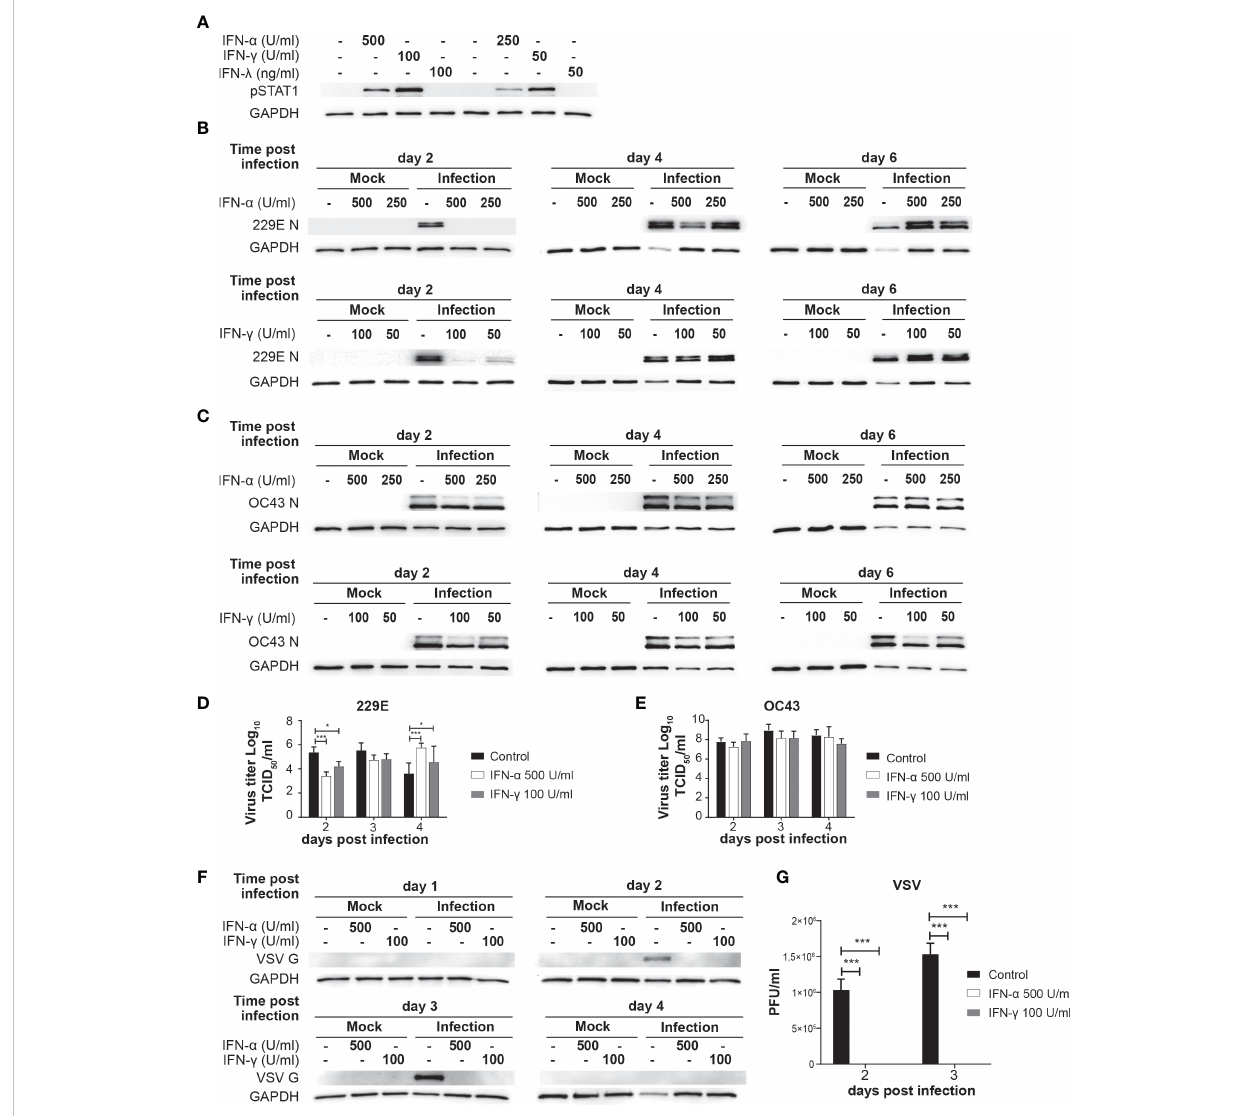
FIGURE 1 IFN treatment delays 229E but not OC43 infection. (A) MRC5 cell were left untreated or treated with IFN- a (500 and 250 U/ml), IFN- g (100 and 50 U/ml) or IFN- l (100 and 50 ng/ml) for 30 min. STAT1 activation was determined by western blot analysis using anti phospho-STAT1 and GAPDH antibodies. (B, C) MRC5 cells were left untreated or treated with IFN- a or IFN- g for 18 hours, and then challenged with 229E (B) or OC43 (C) infection at MOI of 0.01. Western blot analysis of viral protein was conducted using anti 229E N protein (B) , OC43 N protein (C) and GAPDH antibodies. (D, E) TCID 50 assay was performed to measure the progeny virus of 229E or OC43 infected MRC5 cells left untreated or treated with IFNs (n=3). (F, G) MRC5 cells were left untreated or treated with IFN- a (500U/ml) or IFN- g (100U/ml), and then challenged with VSV at MOI of 0.0001. VSV infection was determined by (F) western blot analysis using anti VSV G and GAPDH antibodies and (G) plaque assay using L929 cells (n=3). The amount of progeny virus is shown as plaque forming units (PFU)/ml of samples nontreated or treated with IFN. *p<0.05, ***p<0.001, Two-way